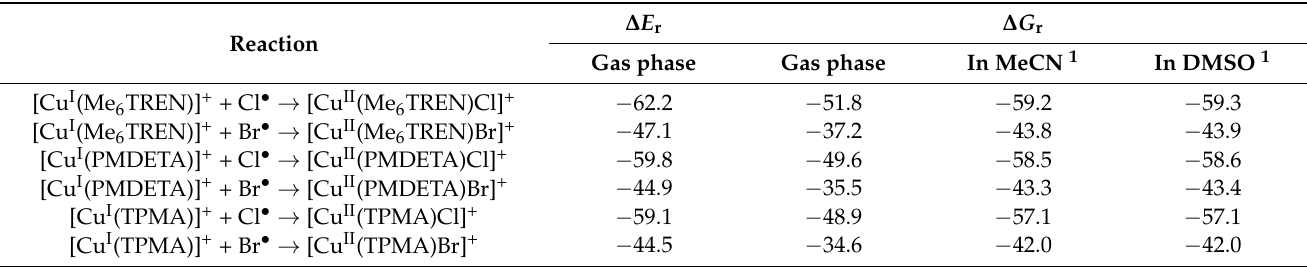
Table 1. ∆ E r and ∆ G r (kcal/mol) of reaction (3) calculated in gas phase and in solution; level of theory: (PCM-)M06/6-311+G(d,p).